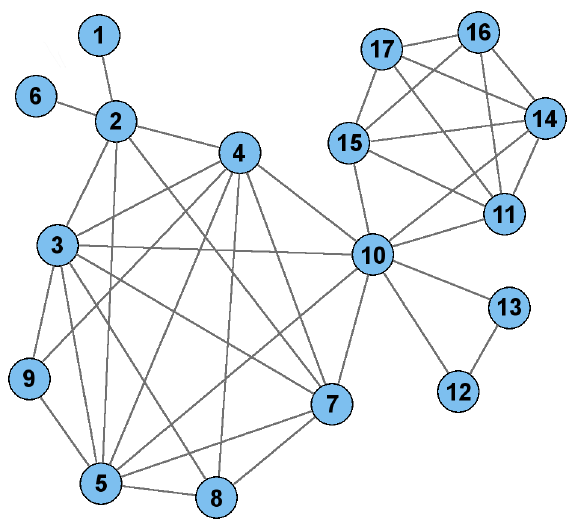
Figure 2. Plot of 17-node bloc, ps_1 . Each node represents a SNP allele and each edge represents a significant correlation between the SNP alleles representing its endpoints. The pattern corresponding to this bloc exhibited a risk association with psoriasis, with an odds ratio of 3.64 (CI: 2.75–4.80) and Bonferroni-corrected p-value of 5.01 6 10 2 16 in the discovery data and odds ratio of 3.86 (CI: 2.98–5.01) and Bonferroni- corrected p-value of 1.81 6 10 2 25 in the validation data.